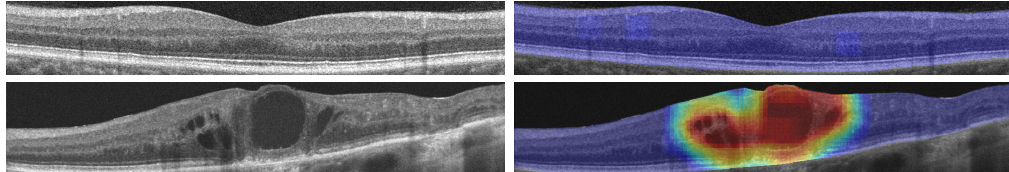
Figure 1. Results from a Spectralis OCT device from Heidelberg Engineering, including a healthy and a pathological example.